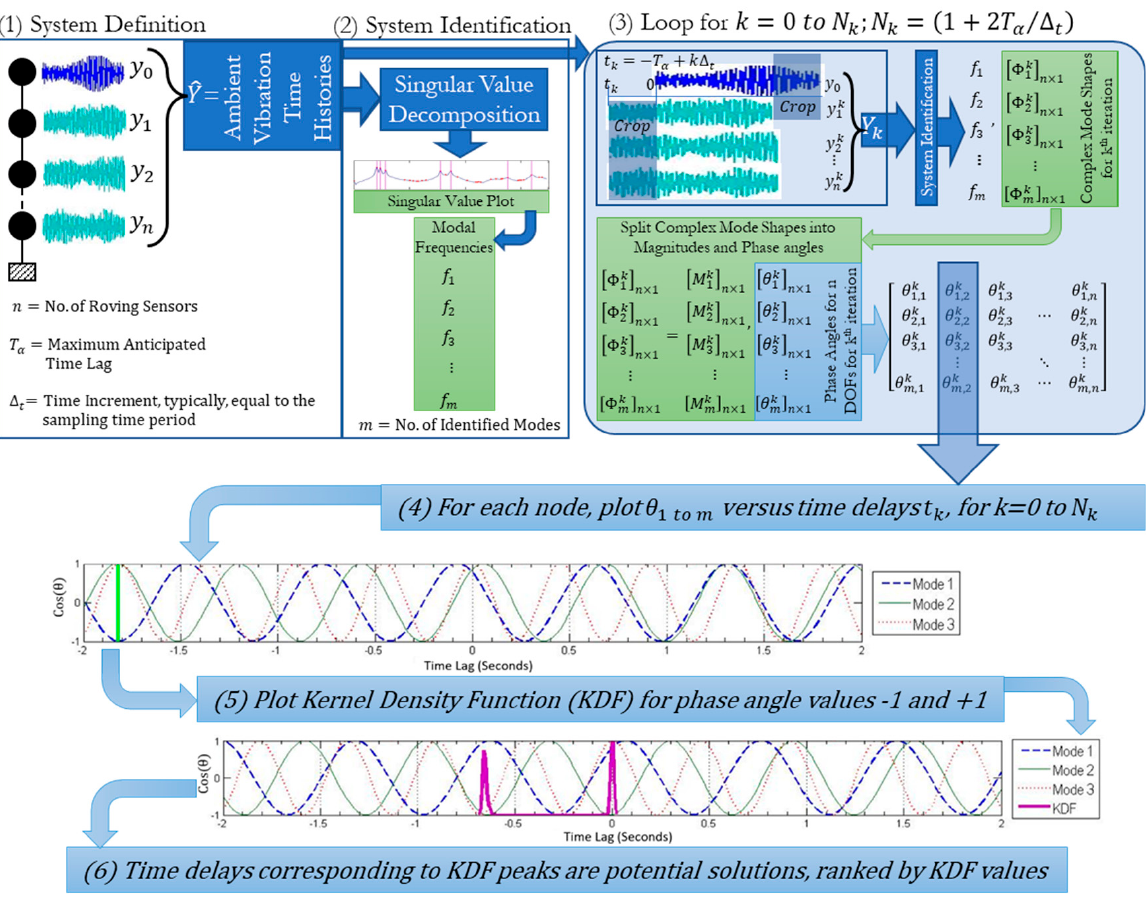
Figure 1. Flowchart of the proposed synchronization algorithm.